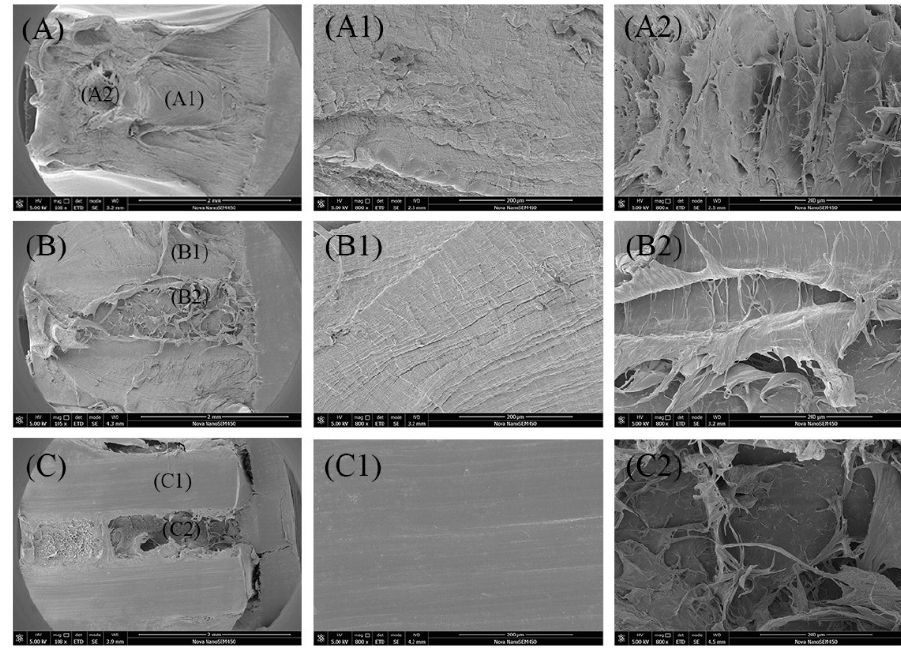
Figure 9. SEM images of the fracture morphology of specimens, the crack propagation direction is from right to left, ( A ) CIM; ( B ) V 1 ; (C) V 2 . ( A1 ), ( A2 ), ( B1 ), ( B2 ) and ( C1 ), ( C2 ) are the corresponding magnified images in ( A ), ( B ) and ( C ), respectively.